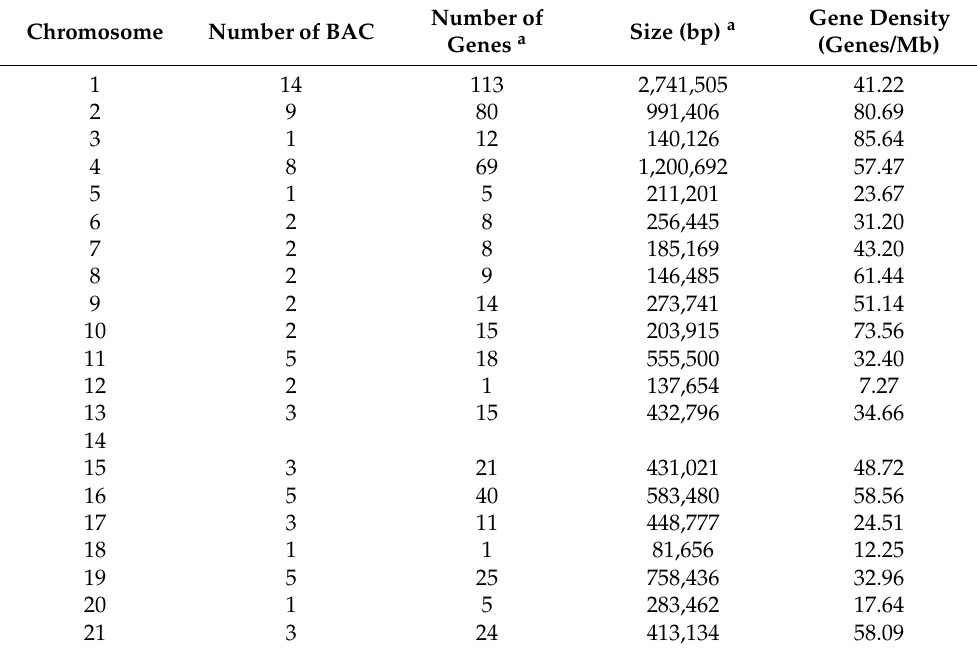
Table 1. Gene density of each chromosome calculated from the number of genes annotated and the total length of all BAC contigs. Chromosome Number of BAC